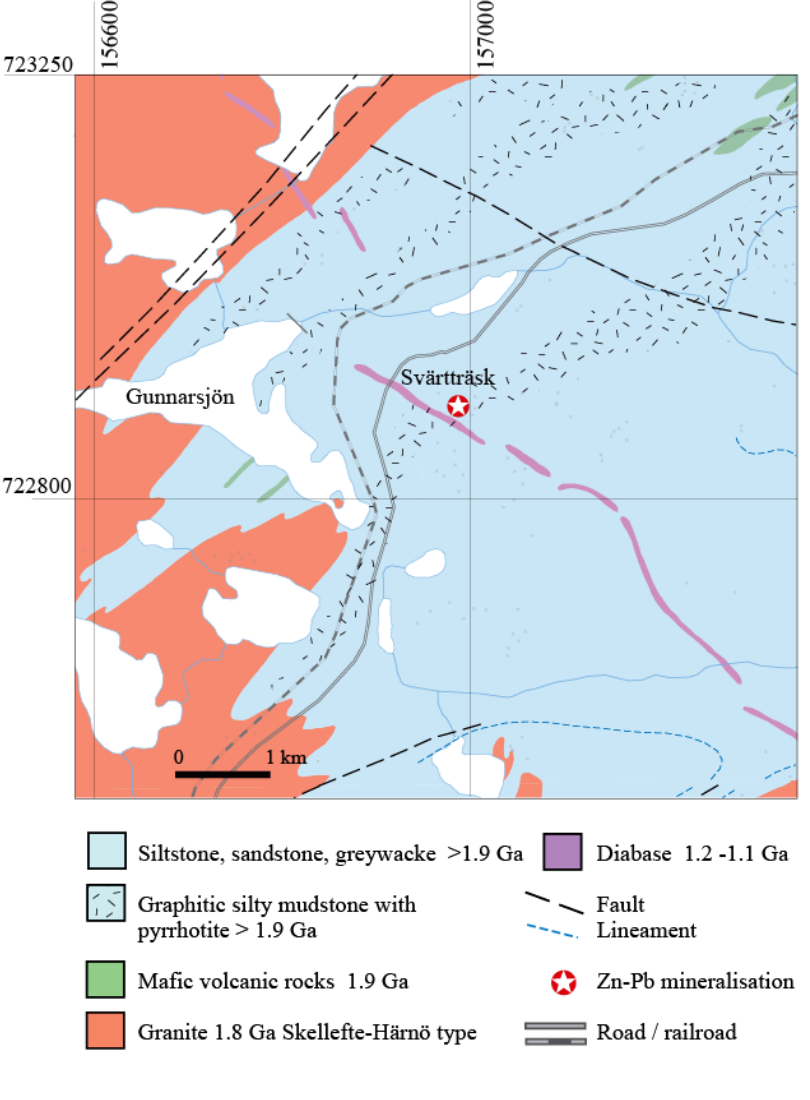
Figure 3. Geological map of the area around the Svärtträsk Zn-Pb